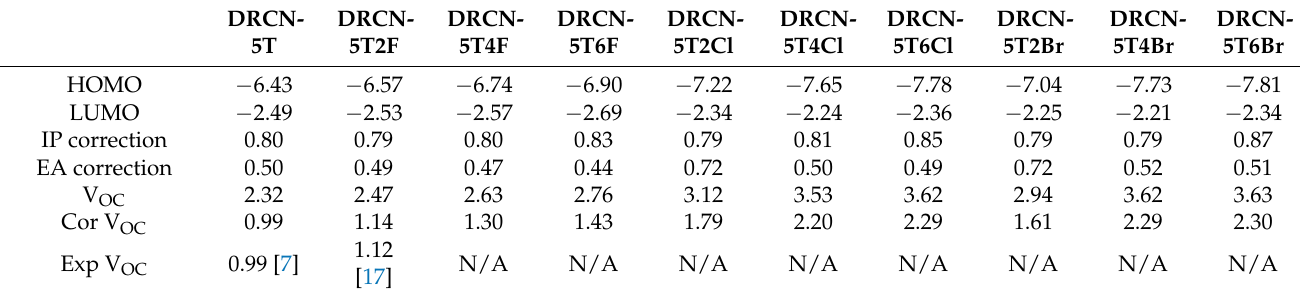
Table 2. The predicted V OC of OSCs with DRCN5T and its derivatives as donor and PC 71 BM as acceptor via Equation (10). EA/IP correction denotes the absolute value of EA D, film -EA D, vacuum or IP D, film -IP D, vacuum , respectively. Unit: V for V OC ; eV for energy. Cor: Corrected; Exp: Experimental. In order to be consistent with the experimental value, we make corrections to all calculated V OC s, i.e., Cor V OC = V OC − 1.33 V, in which 1.33 V is the V OC deviation between experiment and calculation of DRCN5T/PC 71 BM OSC.